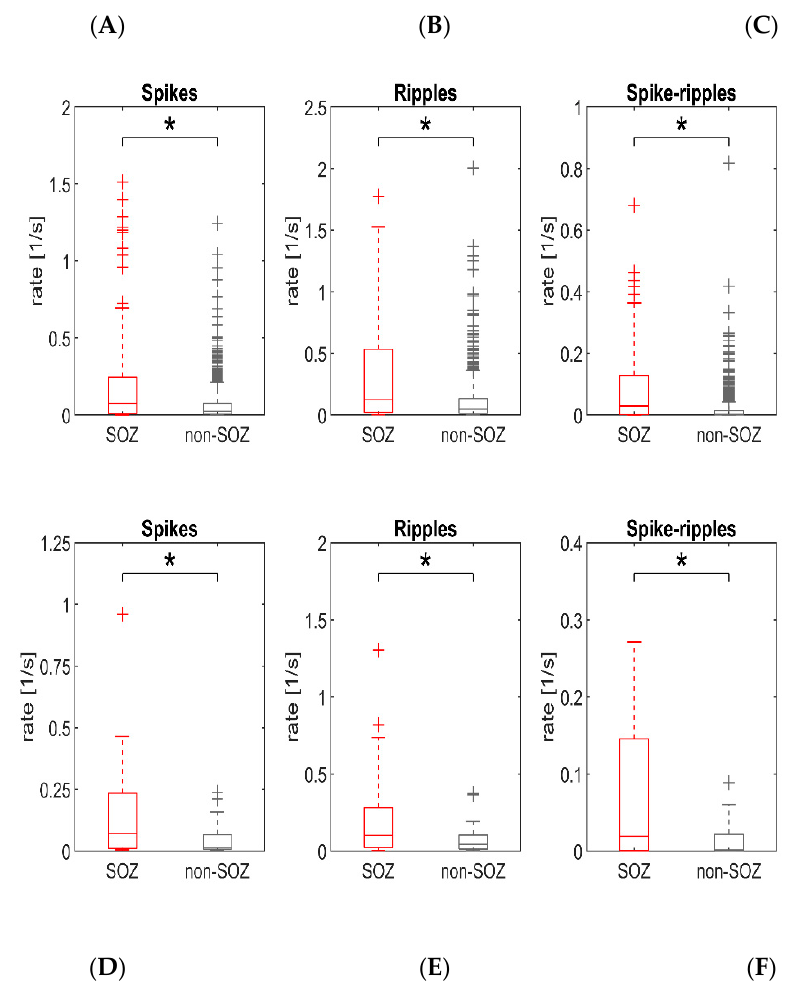
Figure 1. Interictal spikes, ripples and spike-ripples are biomarkers of the seizure onset zone (SOZ) in subdural grid recordings. ( A–C ) Channels pooled across patients. SOZ channels have higher rates of interictal spikes ( A , p < 0.001), ripples ( B , p < 0.001) and spike-ripples ( C , p < 0.001) than non-SOZ channels. ( D–F ) Comparison at the level of individual patients. For each patient, and from both groups of channels, we considered the channel with the median rate as representative. Again, rates of interictal spikes ( D , p = 0.001), ripples ( E , p = 0.004) and spike-ripples ( F , p < 0.001) were higher inside the SOZ.